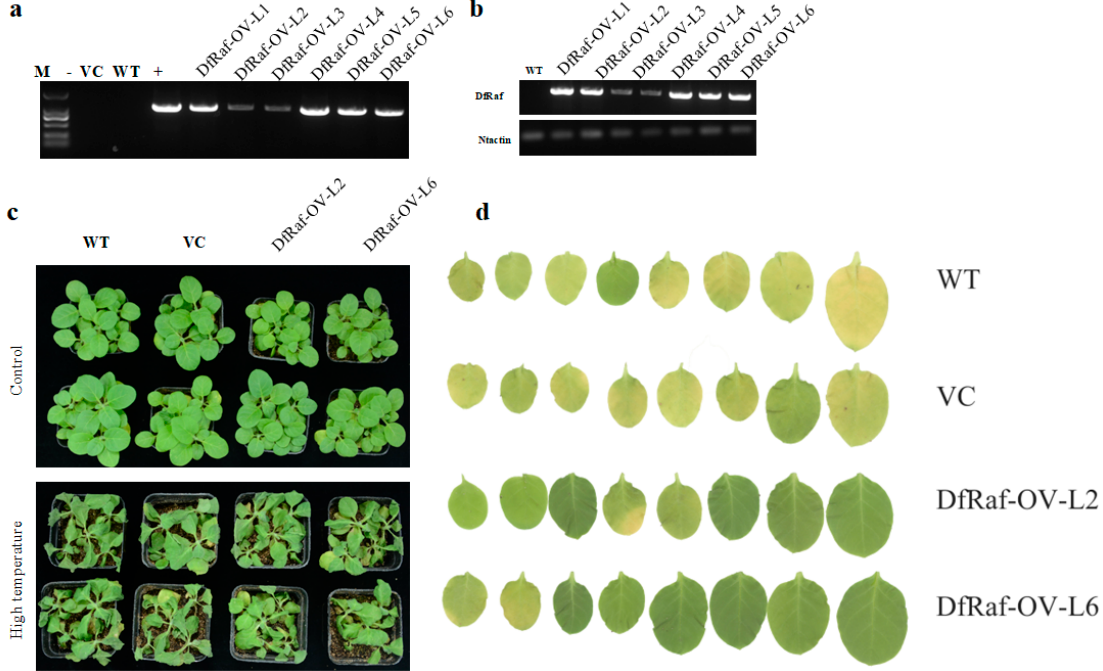
Figure 7. Genomic DNA PCR and semi-quantitative reverse transcription (RT)-PCR identification of transformation with DfRaf and the phenotype of tobacco transformed with the DfRaf gene after heat treatment. ( a ) PCR identification of transformation with DfRaf . M: Trans2K DNA marker; -: ddH 2 O negative control; +: positive control; VC: vector control; WT: wild-type; DfRaf overexpression lines: DfRaf-OV-L1-6. ( b ) Semi-quantitative reverse transcription (RT)-PCR identification of transformation with DfRaf . WT: wild-type; DfRaf-OV-L1-6: transformation with the DfRaf gene. ( c ) Phenotype of tobacco transformed with the DfRaf gene under heat treatment. WT: wild-type; DfRaf-OV-L2 and DfRaf-OV-L6 were transformed with the DfRaf gene. ( d ) Phenotype of the leaves of WT, VC, DfRaf-OV-L2 and DfRaf-OV-L6 under the high-temperature treatment.